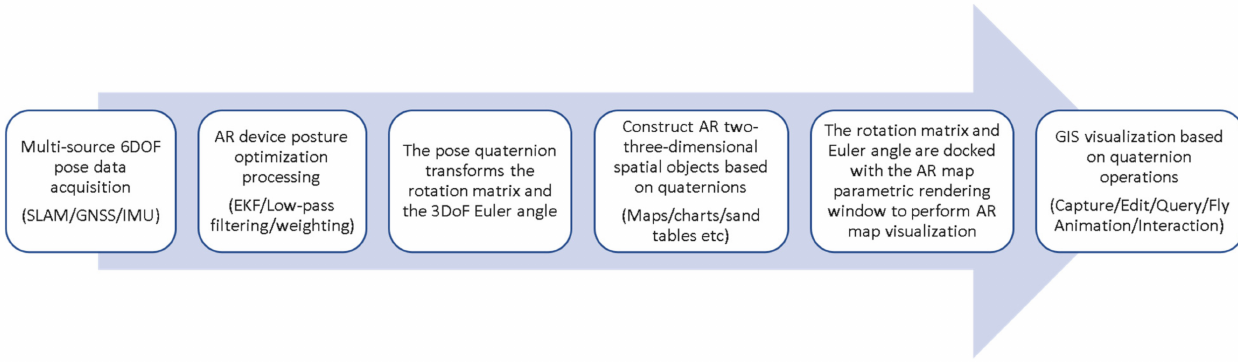
Figure 3. The pipeline of data processing for AR-GIS vector